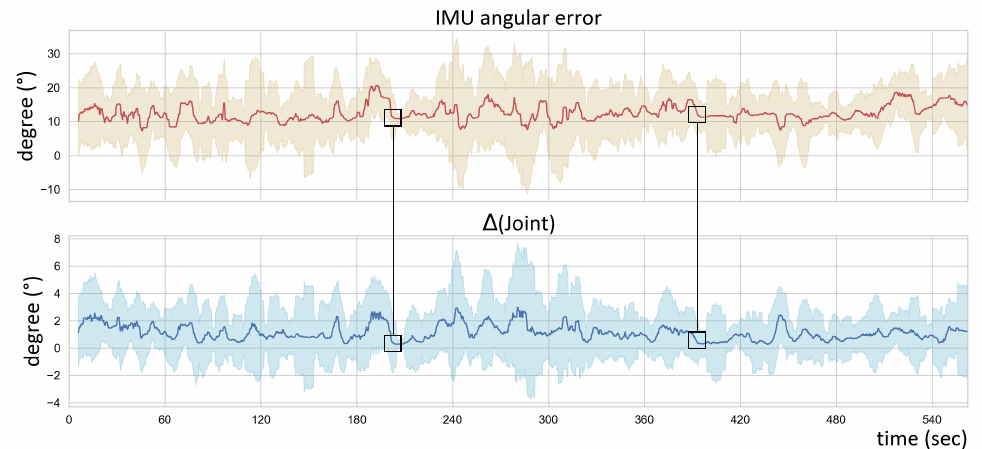
Figure 13. The time-dependent changes in the angular errors of the inertial sensors and the angles of the joints to which the sensors are attached. The errors represent the angle differences between the IMU measurement/synthesized data and the motion capture data within same frame. The errors increased with the continual movement of the sensors and returned to the initial error value when the movement stopped.